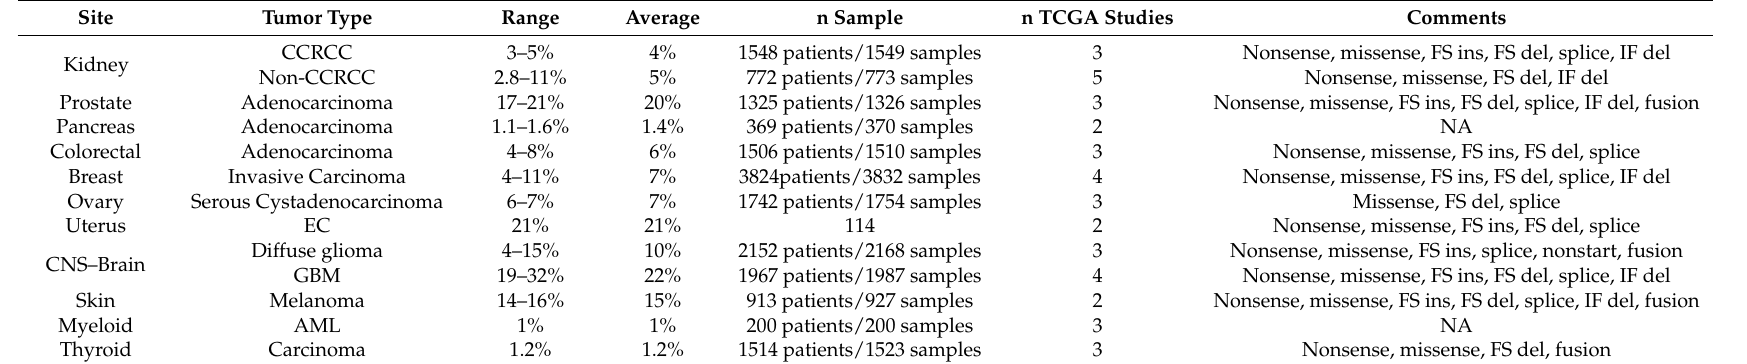
Table 1. PTEN mutations in different tumor